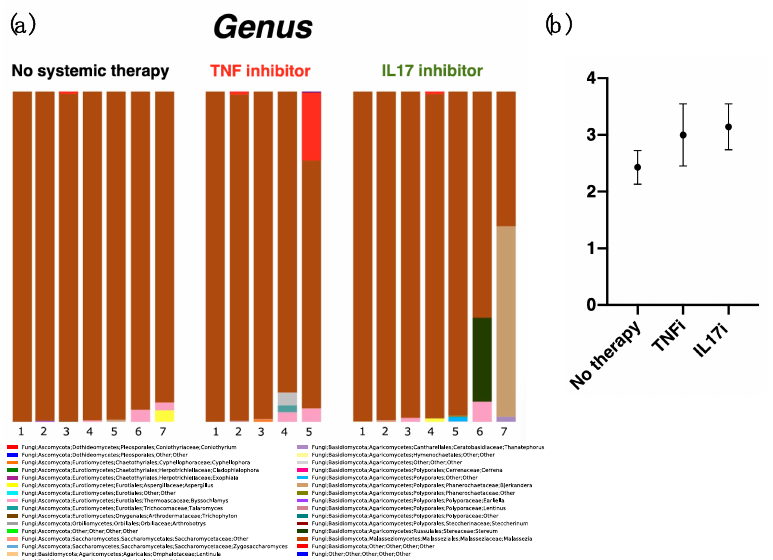
Figure 2. Bar chart showing the relative distribution of fungi at the genus level ( a ). In almost all samples, the major genus was Malassezia (brown bar). Other fungi identified in each sample (> 20%) included an unidentified fungus belonging to class Basidiomycota (red bar) and fungi belonging to the genus Stereum (ocher bar) and genus Bjerkandera (green bar). Genera present at > 1% included Byssochlamys (pink bar); Aspergillus (yellow bar); Talaromyces (gray bar); Thanatephorus (blue bar); and an unidentified fungus belonging to the order Polyporales (purple bar). The average number of genera which occupied over 0.1% of individual samples showed no significant di ff erence between the counts for each group: 2.4 ( ± 0.3 S.E.) for the no-therapy group; 3.0 ( ± 0.5) for the TNFi group; and 3.1 ( ± 0.4) for the IL-17i group ( b